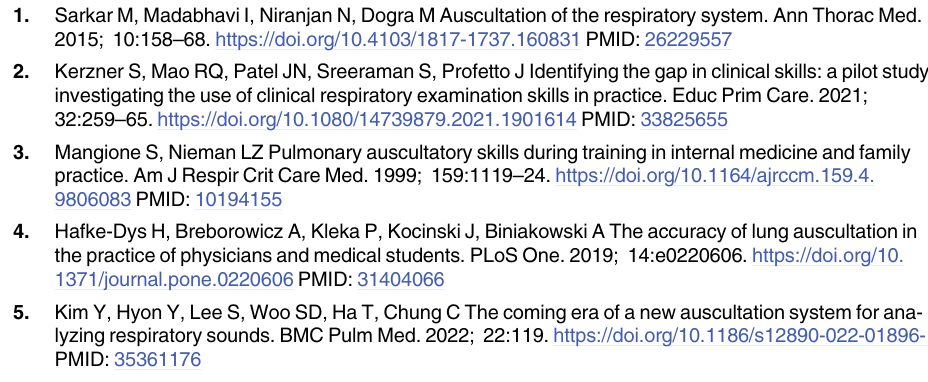
S1 Table. Questionnaire items before and after the training on lung auscultation. S2 Table. P -value in the test of normality of each parameter ( n =